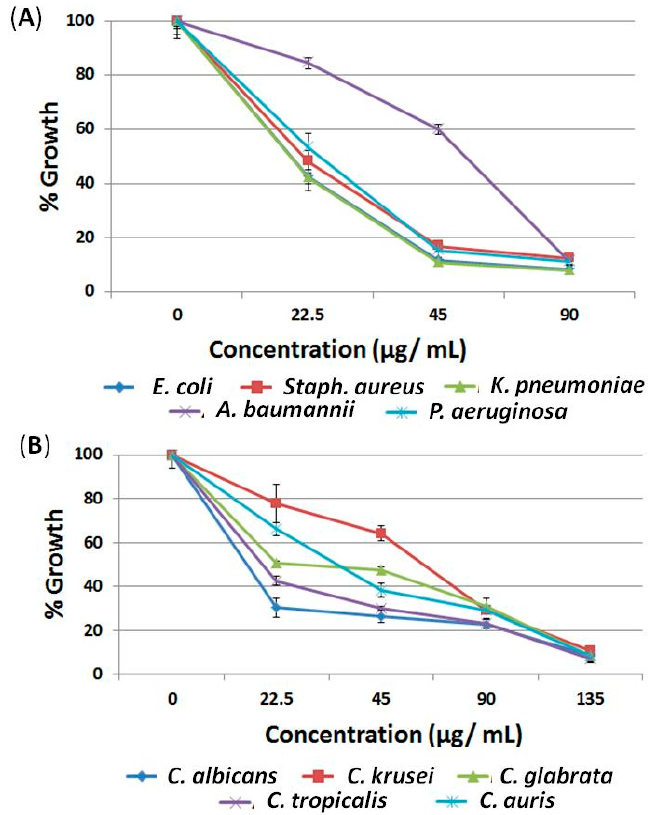
Figure 4. Antibacterial and anti- Candida effects of combined treatment using Calli oil and lawsone. The effects of different concentrations of combined substances on ( A ) Gram-negative and Gram-positive bacteria and ( B ) different Candida spp. Combination of lawsone and Calli oil showed a synergistic effect on MDR microbes with 90 µg/mL and 135 µg/mL caused more than 90% inhibition of tested bacterial spp. and Candida spp., respectively. The data display the mean of the percentage of microbial growth at different concentrations ± standard error of the mean.